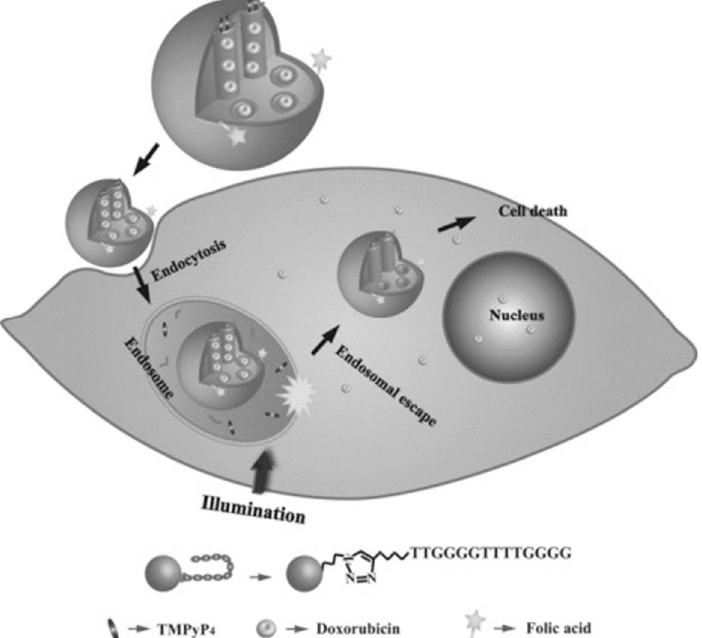
Figure 12. Representation of a novel nano-system for targeted intracellular drug delivery composed by photo-sensitizer-incorporated G4 DNA-capped mesoporous silica nano-particles. This system is composed by a photo-sensitizer (TMPyP4) that upon light irradiation generates ROS, leading to cleavage of G4 DNA ((G 4 T 4 G 4 ) 2 ) capping agent and allowing doxorubicin release. The nano-system is internalized via folate receptor-mediated endocytosis. Copyright (2013) Wiley. Used with permission from Chen, C.; Zhou, L.; Geng, J.; Ren, J.; Qu, X. Photo-sensitizer-incorporated quadruplex DNA-gated nano-vechicles for light-triggered, targeted dual drug delivery to cancer cells. Small. John Wiley and Sons, Inc.